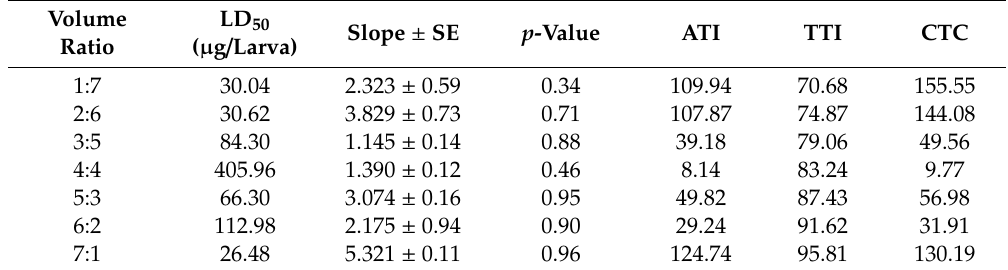
Table 5. Contact toxicity and CTC of carvone and limonene mixture against larvae of T. castaneum .